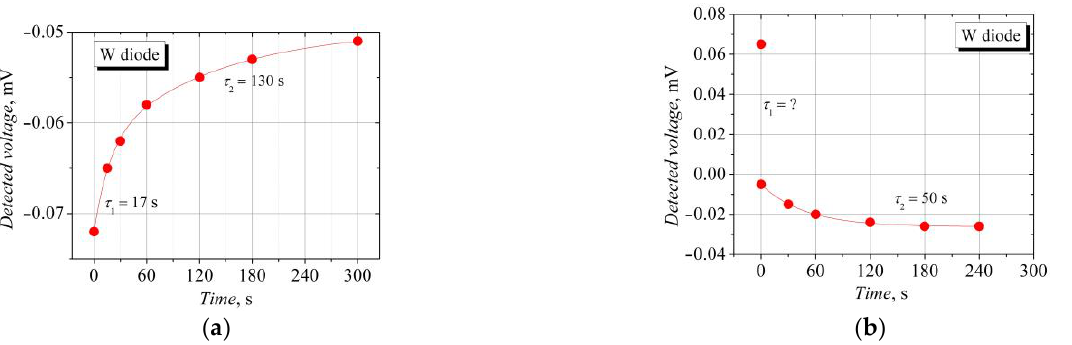
Figure 8. The relaxation of the voltage detected across the W-diode after it was affected by a strong microwave electric field ( a ) and after its illumination with visible light ( b ). Lines indicate approximation via exponential functions.